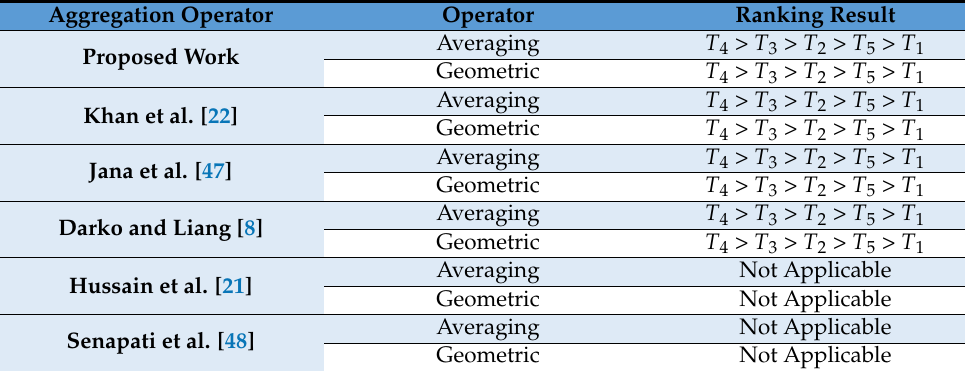
Table 14. The comparison of current and previous approaches.